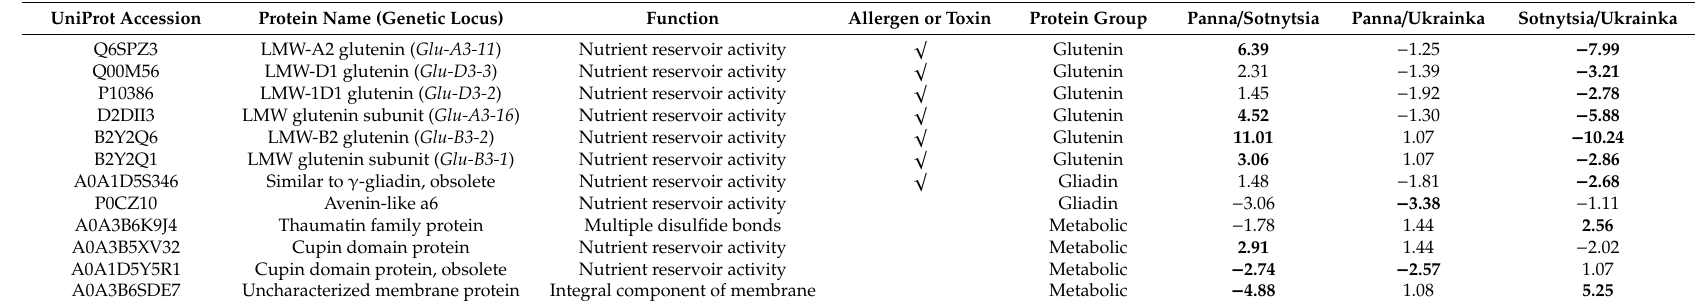
Table 2. Di ff erentially abundant proteins among wheat cultivars revealed by direct label-free mass spectrometry quantification. Bold values indicate significant di ff erences in the respective comparison (ratio ≥ 2.5 and Tukey’s test p ≤ 0.01). Positive value of proportion—protein is more abundant, negative value—protein is less